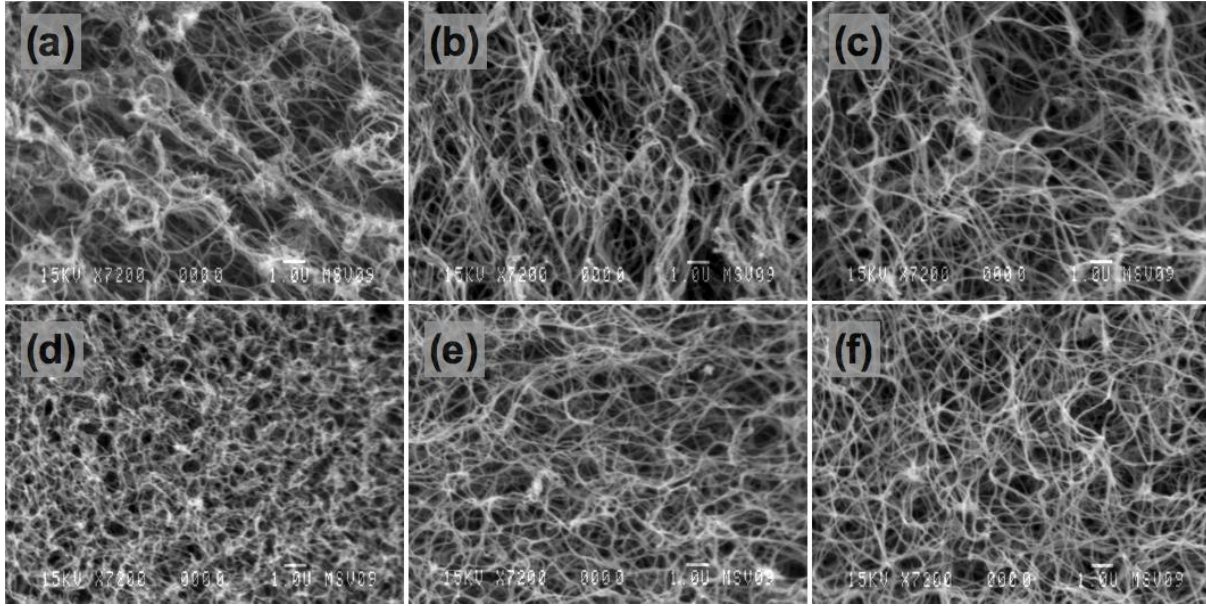
Figure 2. SEM images (7200×) of samples prepared at different pHs, ionic strengths and set at T = 21 °C. ( a ) Sample prepared at pH 7 and ionic strength c1. ( b ) Sample prepared at pH 7 and ionic strength c4. ( c ) Sample prepared at pH 7 and ionic strength c7. ( d ) Sample c4. ( f ) Sample prepared at pH 10 and ionic strength c7.